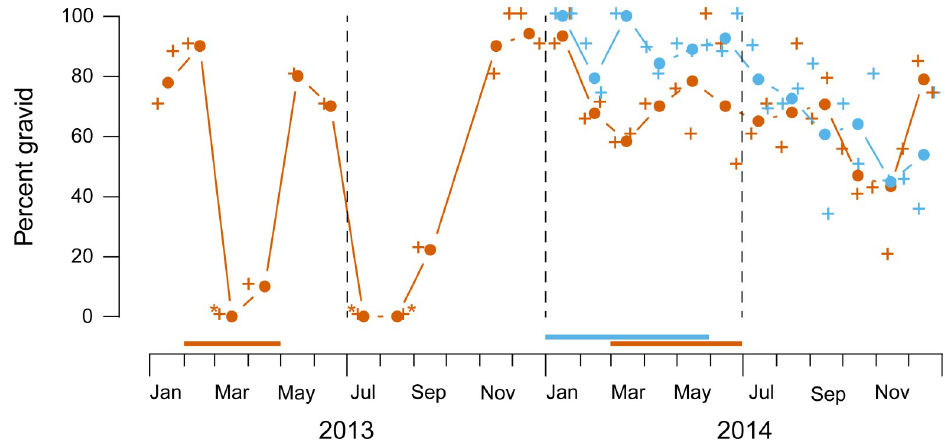
Fig 3. Frequencies of gravid (vs. undeveloped) Philornis females. Data from 2013–2014 at the lowland site are shown in orange, and data from 2014 at the highland site are shown in blue. Crosses are raw proportions of n = 7–19 females (or � n = 2). Filled circles with lines are pooled proportions plotted at midmonth, estimated with binomial regression. Horizontal bars above calendar scales represent breeding seasons of known